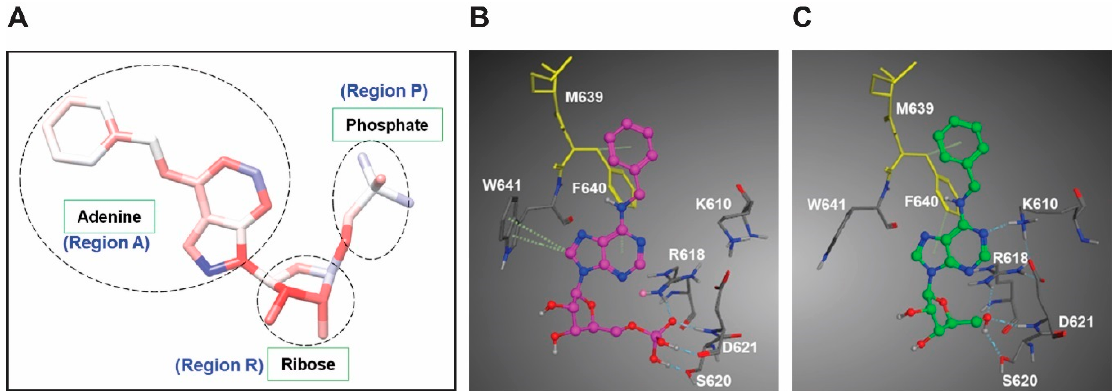
Figure 7. Comparison of the docking of IST5 vs. IST-M to Stat5 in silico. ( A ) Interaction-based color-coded atoms of our inhibitor IST5 and the three regions for modifications. Hydrogens are not shown. ( B ) Comparison of docking of IST5 (1 with the 5 ′ -phosphate group) ( A ) and compound. 2 without 5 ′ -phosphate group ( B ) to Stat5a.